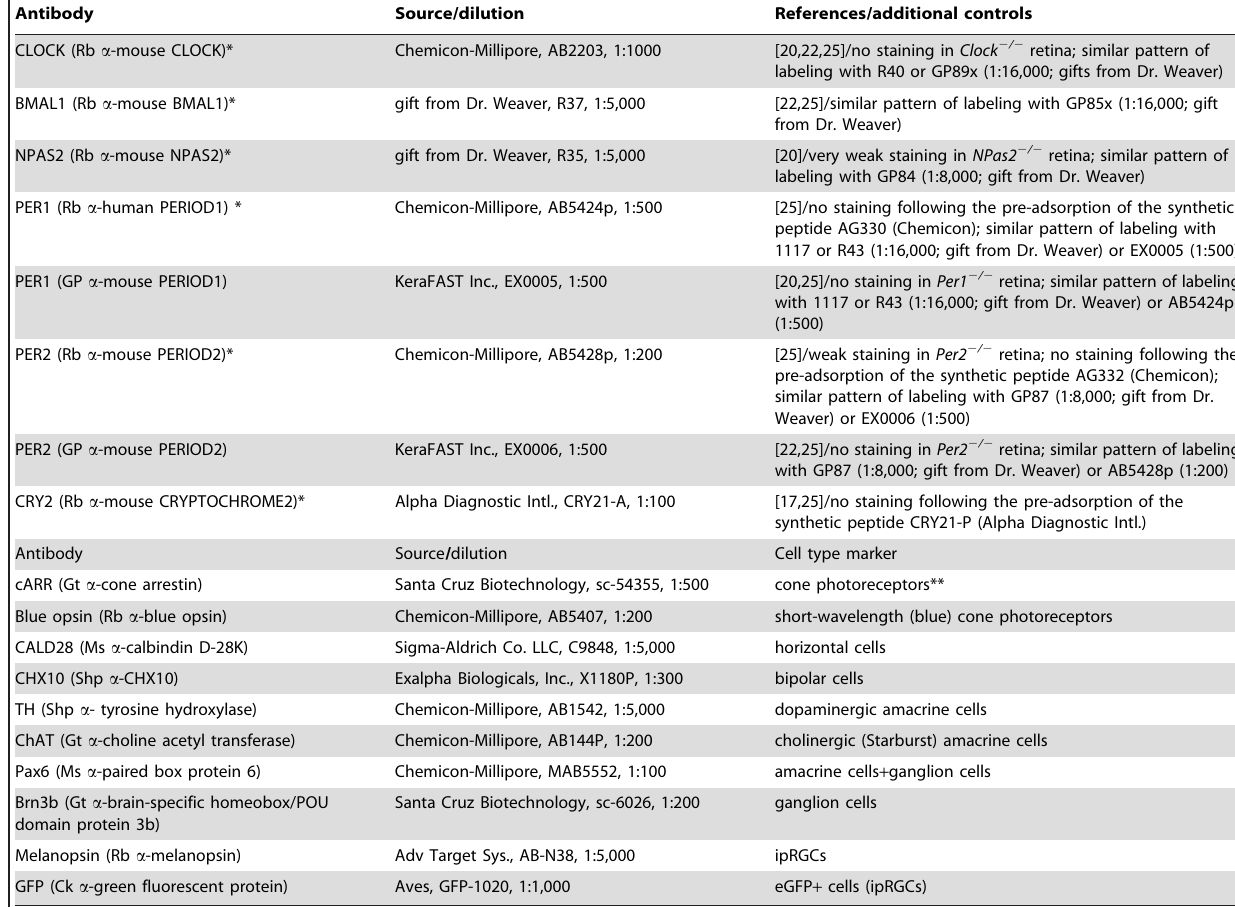
Table 1. List of the antibodies used in this study.